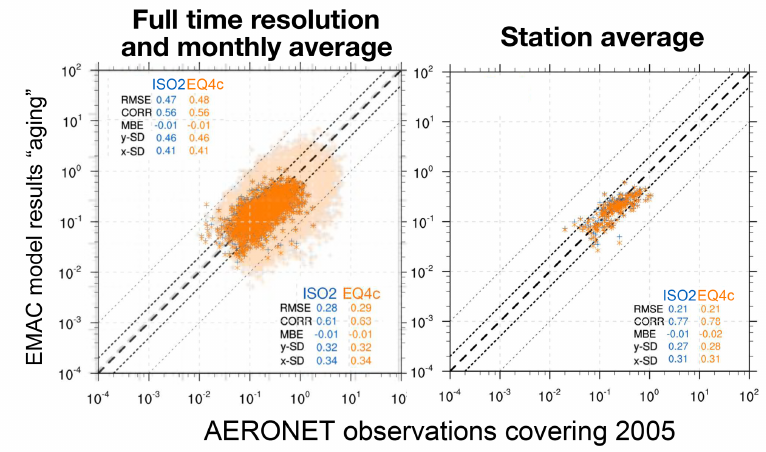
Figure 14. EMAC AOD based on the aging setup versus AERONET observations for the year 2005, complementing Fig. 9. Different time averages (full time resolution in light colors with statistics in the upper left corner) are shown for the results of ISORROPIA II (ISO2) and EQSAM4clim (EQ4c) based on 537 AERONET station locations (shown in Fig. S1).